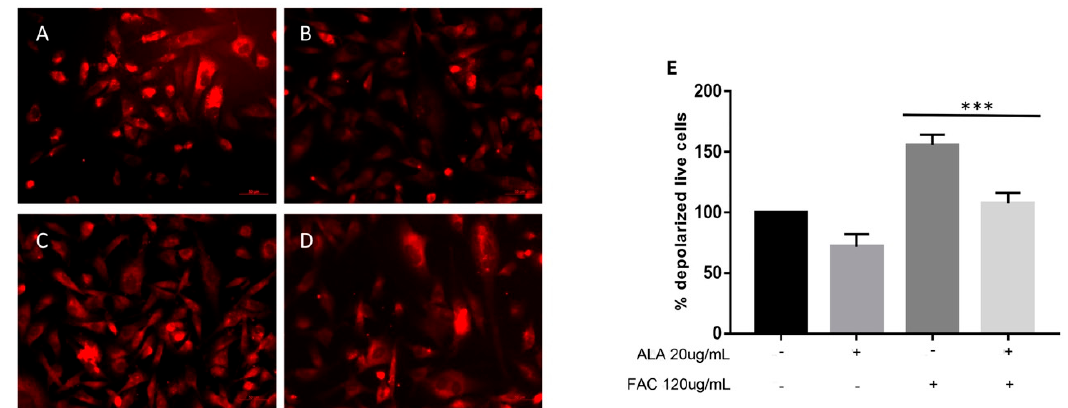
Figure 2. Immunofluorescences of TUFM localization in untreated HS-5 cell cultures ( A ) following FAC (120 µ g/mL for 24 h) treatment alone ( B ) and with ALA (20 µ g/mL) alone or in combination with FAC ( C , D ) and mitochondrial membrane depolarization evaluation ( E ). TUFM detection was performed by incubation with anti-goat monoclonal antibody followed by secondary antibody conjugated to Rhodamine (red). Counterstaining of cells was performed by using the nuclear dye, DAPI (blue); (Scale bars 10 µ m). Mitochondrial membrane depolarization evaluation after FAC treatment alone and in combination with ALA performed by FACS analysis (*** p < 0.0001 vs. FAC alone treatment). All values are presented as mean ± SE of four experiments in duplicate.